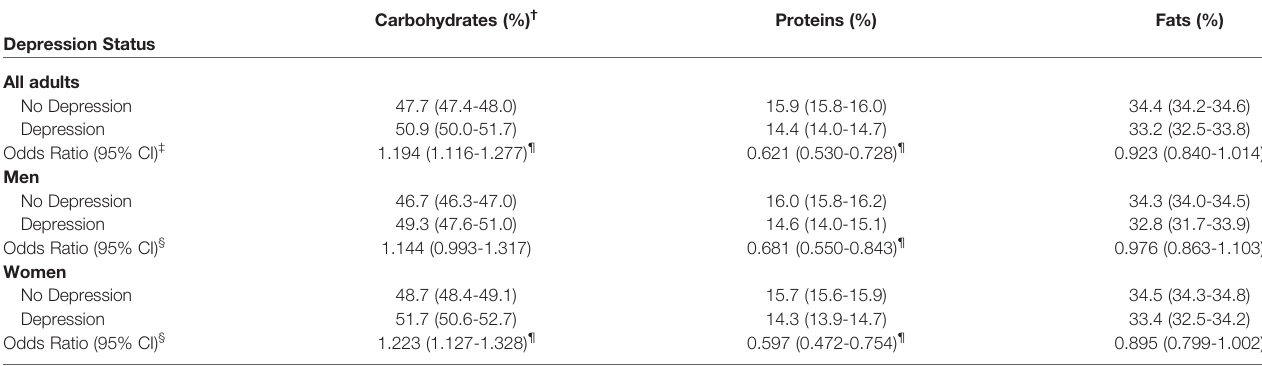
TABLE 2 | Adjusted association between calories from each nutrient and depression in United States, 2005-2016.